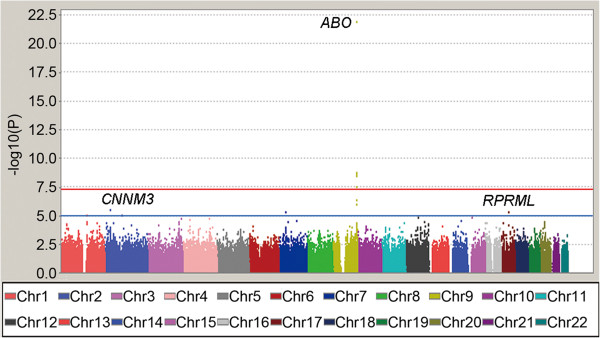
Manhattan plot of genome-wide association analyses for ALP. The horizontal axis shows the chromosomal positions while the vertical axis shows -log10 P values from the test of association by linear regression analysis. The red horizontal line shows the P value of 5.0 × 10-8, and the blue horizontal line corresponds to a P value of 1.0 × 10-5.